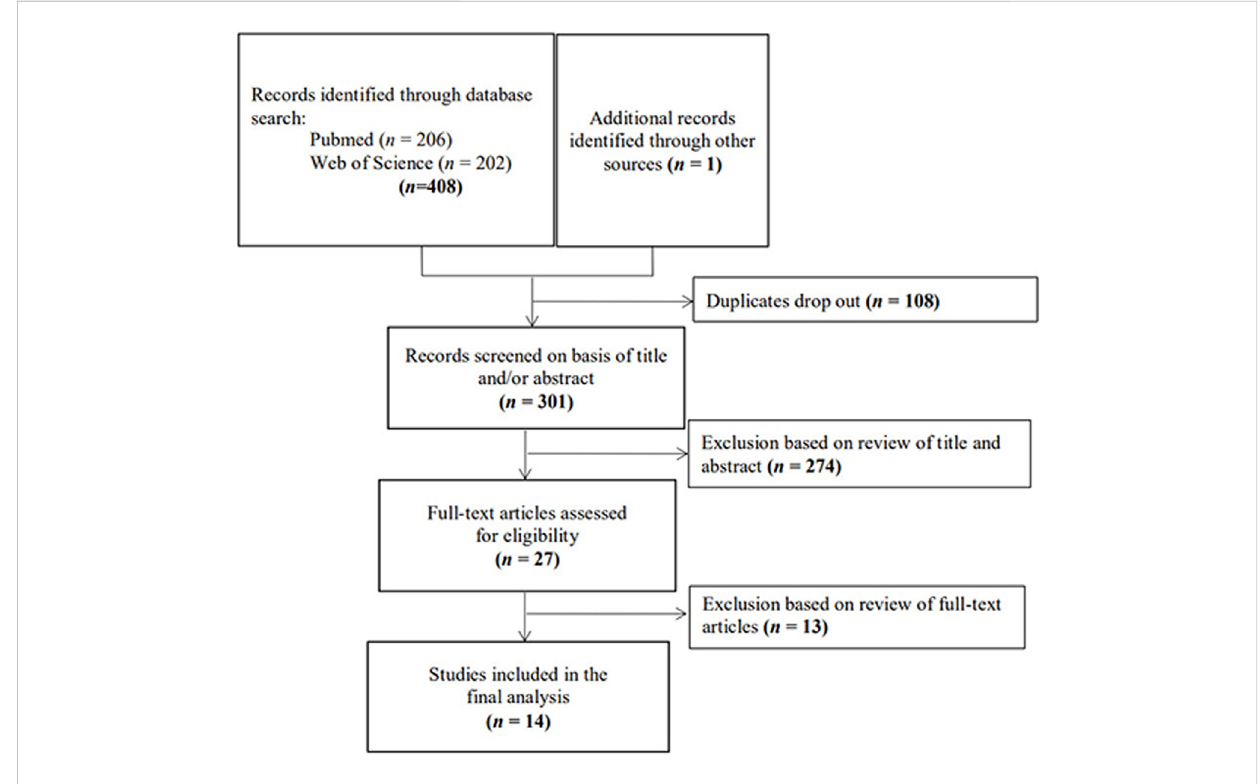
FIGURE 1 Flow chart of article identi fi